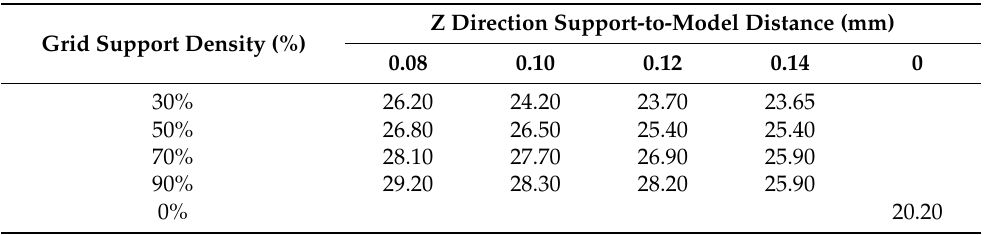
Table 4. Average compressive strength (MPa) of experimental components with different influencing factors under grid-support